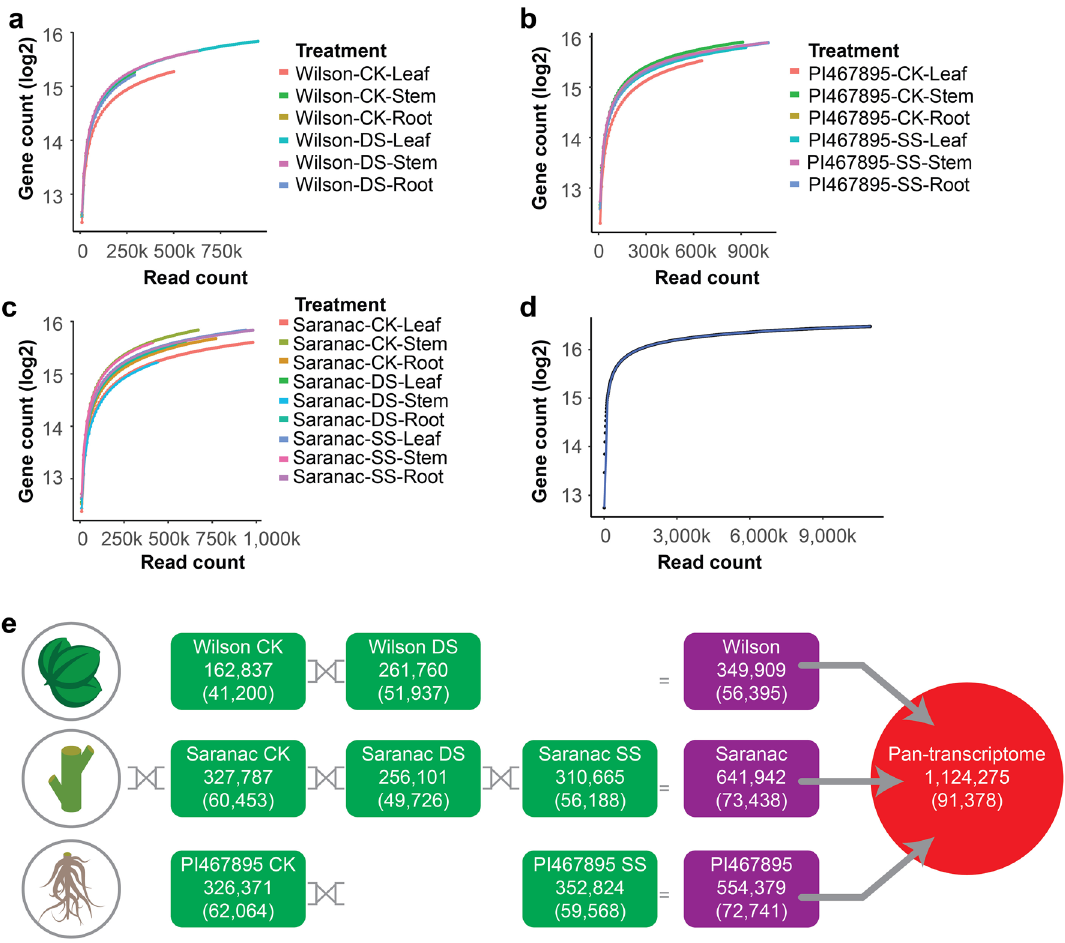
Figure 1. Analysis of the Medicago sativa pan-transcriptome. Gene saturation curves in ( a ) Wilson, ( b ) PI467895, ( c ) Saranac transcriptomes and ( d ) pan-transcriptome. e Non-redundant isoforms and genes in Wilson, Saranac and PI467895 by control (CK), drought stress (DS) and salt stress (SS) (green boxes). Different treatments and genotypes were used to obtain non-redundant isoforms and genes (purple boxes). Finally, they were merged to obtain the pan-transcriptome (red